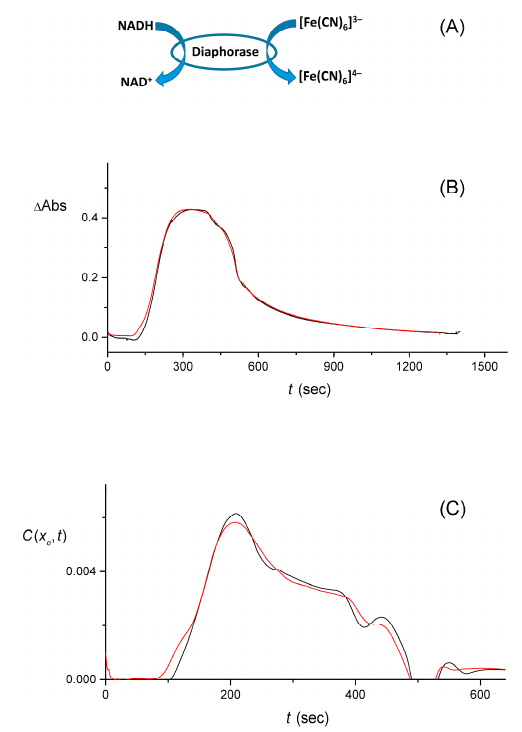
Figure 9. ( A ) Schematics of the ferricyanide, [Fe(CN) 6 ] 3 − , being reduced by NADH, in a process biocatalyzed by diaphorase. The reaction products are β -nicotinamide adenine dinucleotide (NAD + , oxidized form) and ferrocyanide, [Fe(CN) 6 ] 4 − . Note that the optical absorbance ( λ max = 420 nm) decreases upon reduction of [Fe(CN) 6 ] 3 − ; ( B ) Two experimentally measured signals, (cid:1845)((cid:1872)) , for a rectangular pulse with the biocatalytic process ongoing (activated by adding 1 mM NADH); ( C ) Shows the numerically reconstructed input pulses, (cid:1829)((cid:1876) (cid:3030) , (cid:1872)) , generated from smoothed-out (cid:1845)((cid:1872)) .